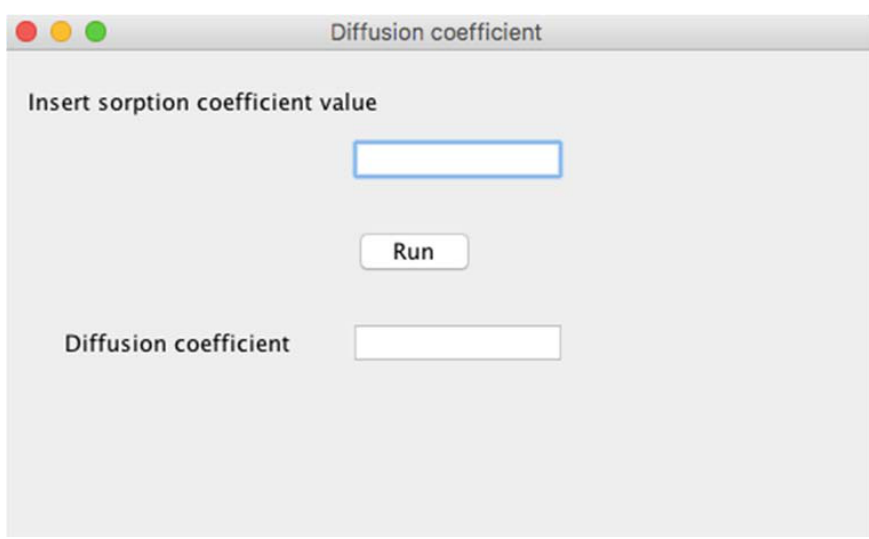
Figure 4. Menu window: More options.